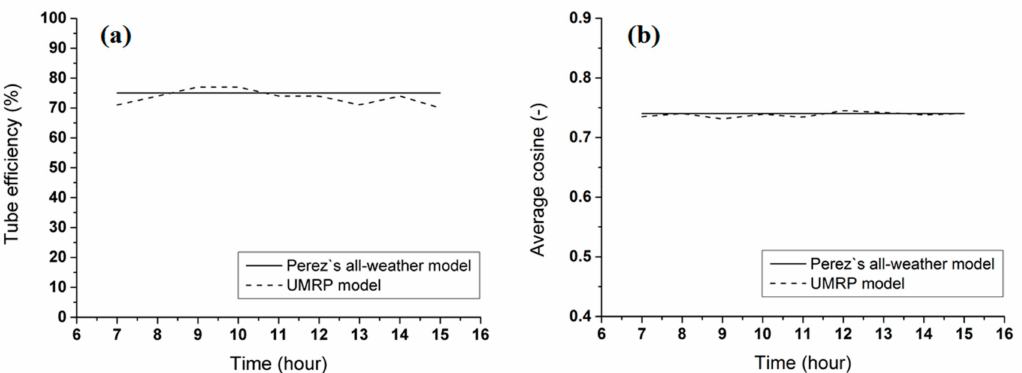
Figure 7. The same as in Figure 6, but for the overcast sky, 24 February